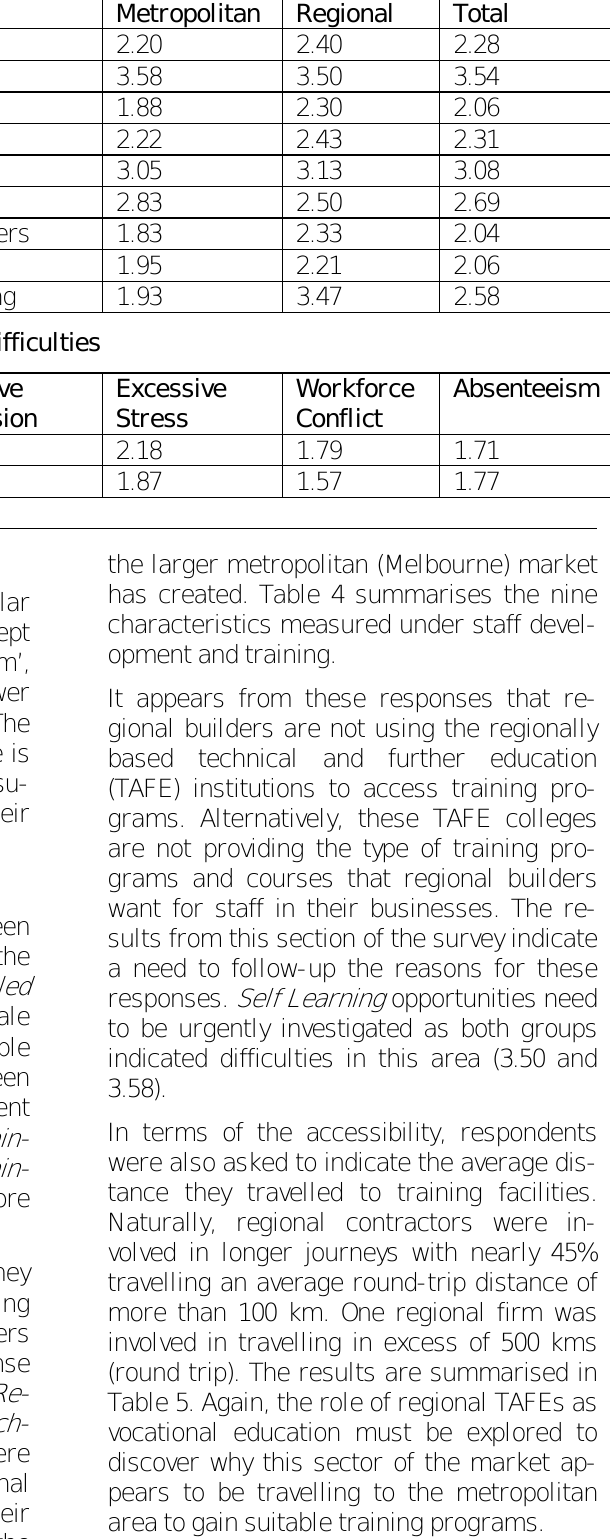
Table 4: Mean Likert values for Staff Development/Learning Difficulty Experienced